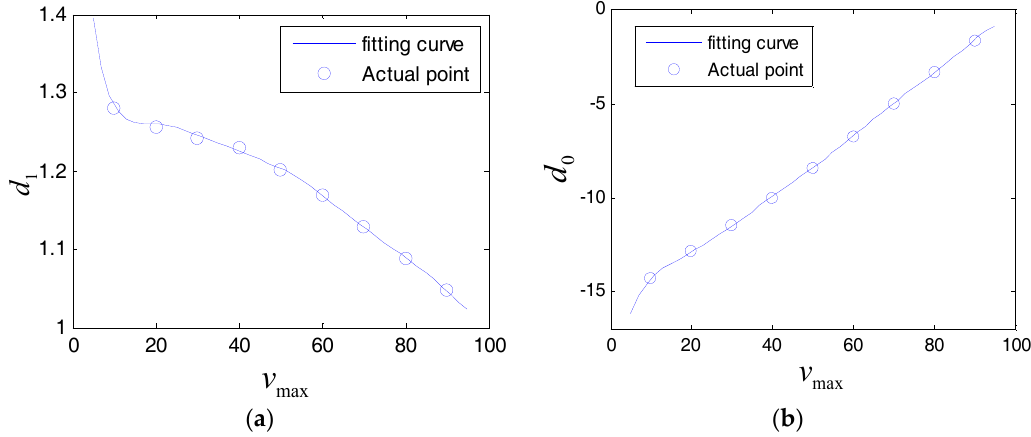
Figure 8. The relationship between similarity factors and maximum ( a ) The relationship between v max and d 1 ( b ) The relationship between v max and d 0